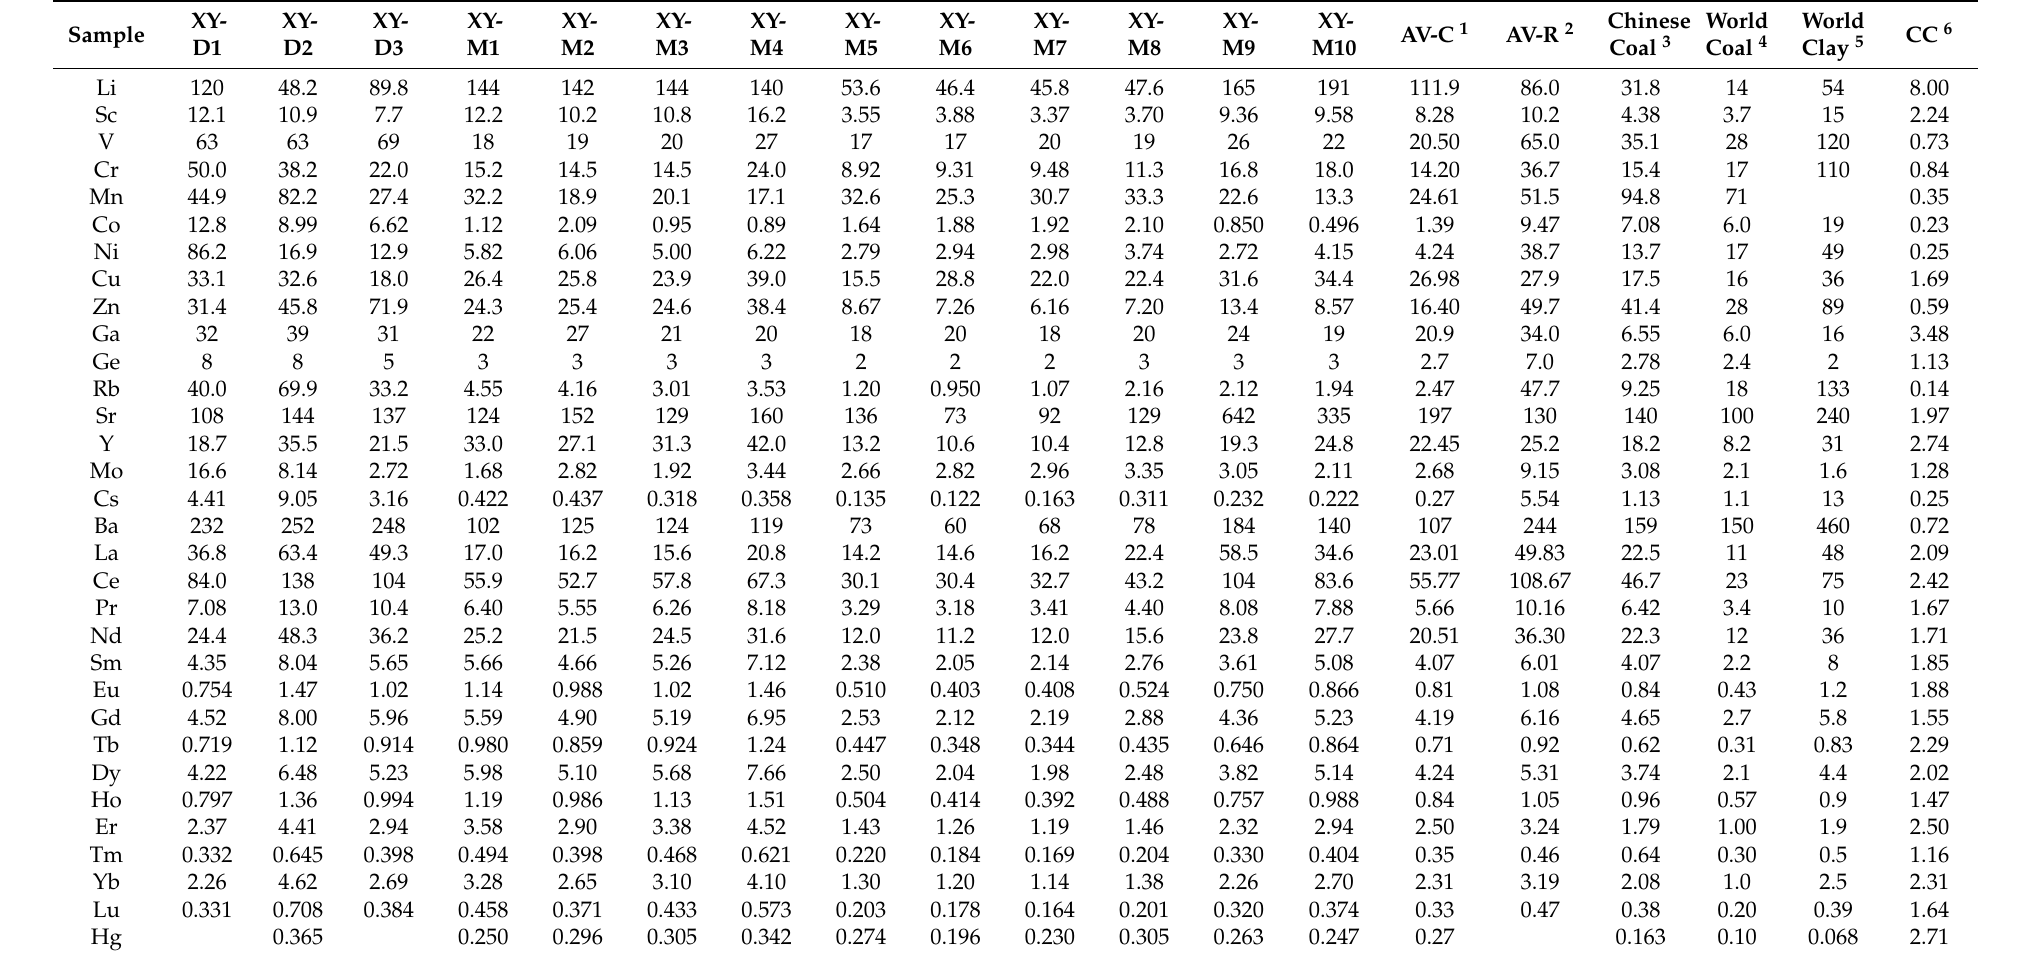
Table 4. Concentrations of trace elements ( µ g/g) in the No. 9 coal and related roof samples from the Xinyuan